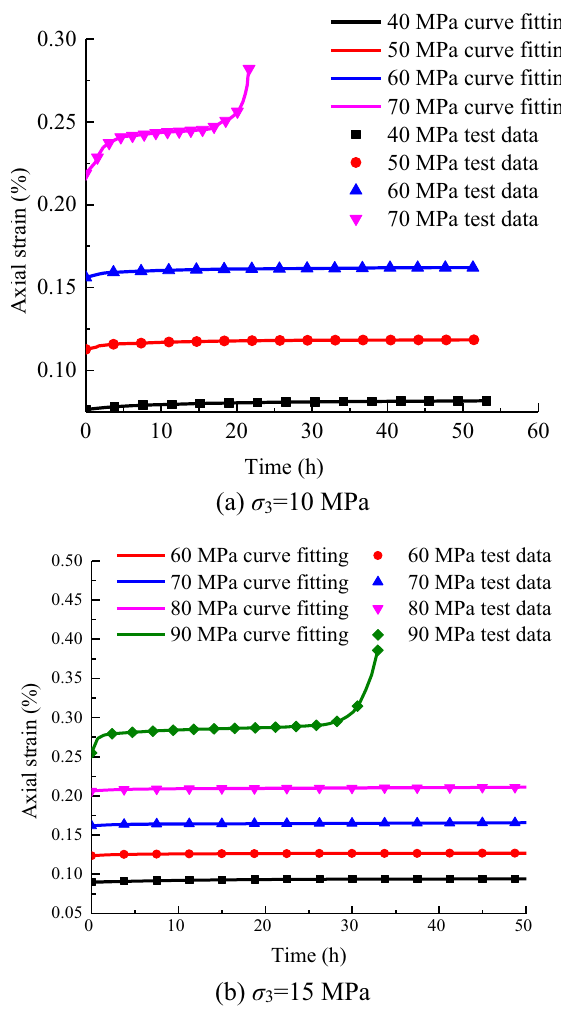
Figure 20. Experimental results compared with the calculated